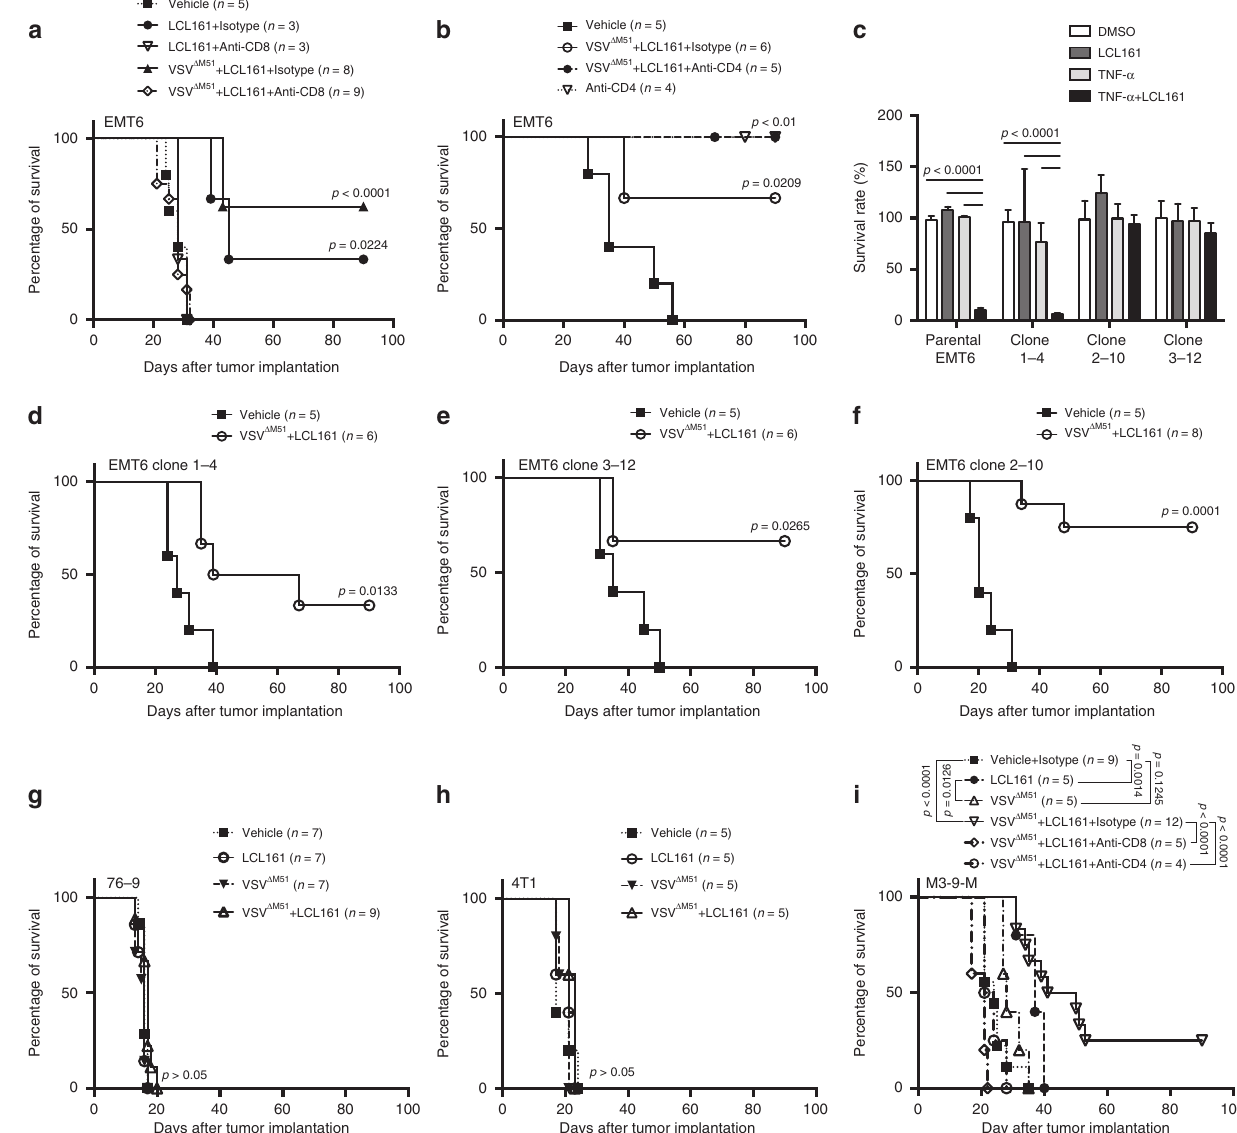
Fig. 1 LCL161 and VSV Δ M51 combination therapy induces CD8 + T-cell-mediated tumor regression independent of TNFR1 signaling in cancer cells. a Overall survival of EMT6 tumor-bearing mice treated with LCL161 ± VSV Δ M51 ± CD8 neutralizing antibody (or isotype control; triplicate experiments; log-rank test). b Overall survival of EMT6 tumor-bearing mice treated with LCL161 + VSV Δ M51 ± CD4 neutralizing antibody (or isotype control; duplicate experiments; log-rank test). c Cell viability of parental EMT6 cells and three EMT6 TNFR1-CRISPR clones assayed for TNFR1 bioactivity by treatment with LCL161 + TNF α (100 ng mL − 1 ), measured by Alamar Blue 48 h later ( n = 3 biological replicates per experiment; triplicate experiments; mean ± SD; ANOVA with Tukey ’ s multiple comparisons test). d – f Overall survival of EMT6 TNFR1 + / + ( d clone 1-4) and EMT6 TNFR1 − / − ( e , f clones 2 – 10 and 3 – 12) bearing mice treated with LCL161 + VSV Δ M51 (duplicate experiments; log-rank test). g – i Overall survival of 76 – 9 g , 4T1 h and M3-9-M i tumor-bearing mice treated with LCL161 + VSV Δ M51 (M3-9-M: triplicate experiments; 76 – 9 and 4T1: single experiment). Effect of CD4 or CD8 (or isotype control) neutralization is shown for M3-9-M (single experiment; log-rank